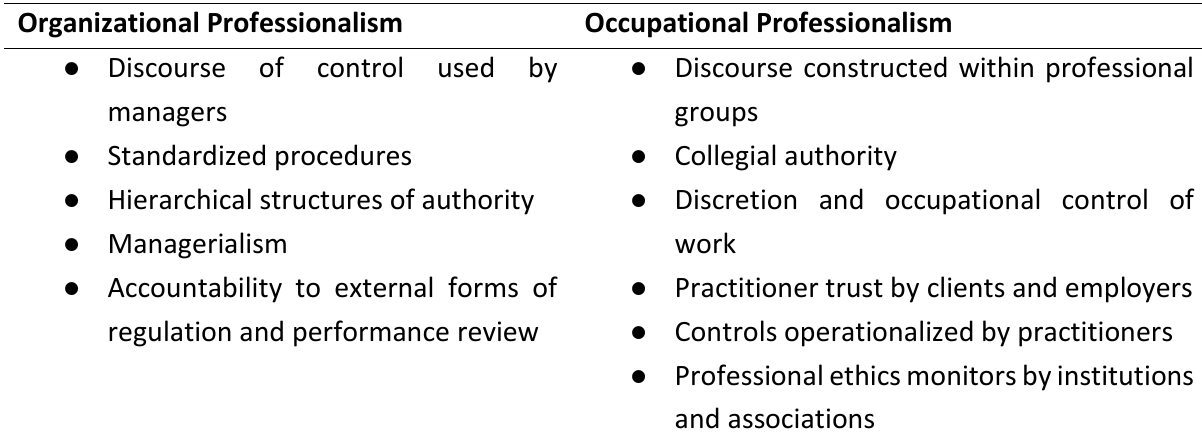
Table 1. Ideal types of Professionalism in knowledge-based work (Evetts, 2009, p. 263) Organizational